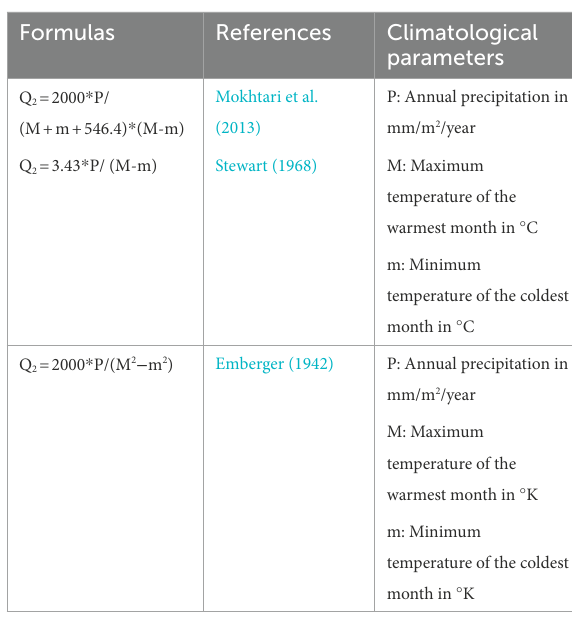
TABLE 1 Emberger bioclimatic quotient (Q 2 ) formulas.